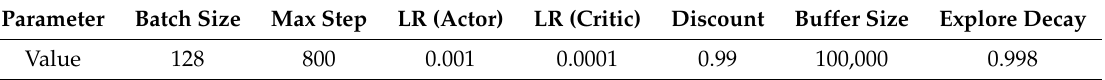
Table 1. Hyperparameters of the networks on a single-robot navigation task.